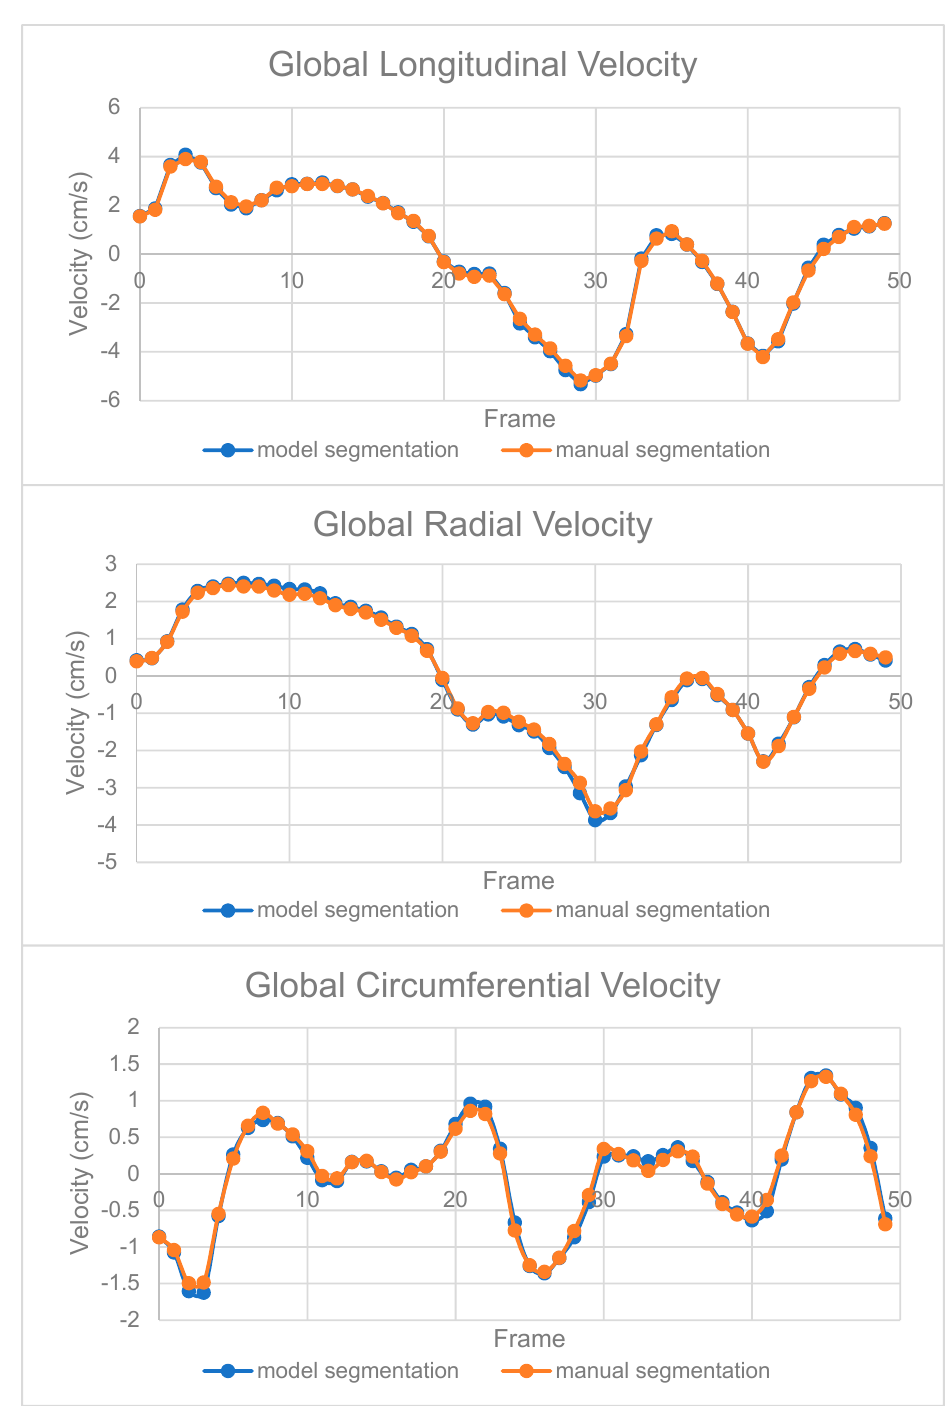
Figure 5. Global velocity curves of the longitudinal, radial and circumferential myocardium velocities per cine slice for a sample cine slice from a subject generated from the manual segmentation and our automated segmentation system.